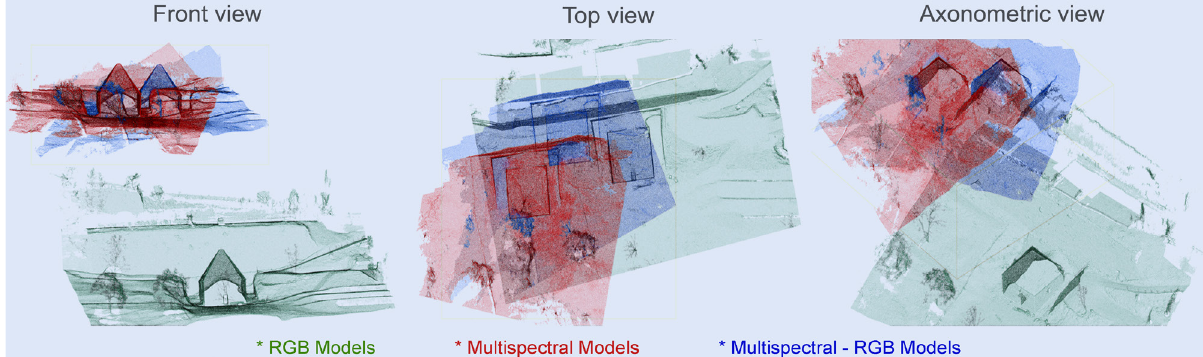
Figure 5. Georeferencing error of the models reconstructed from the GNSS positioning data of the two different